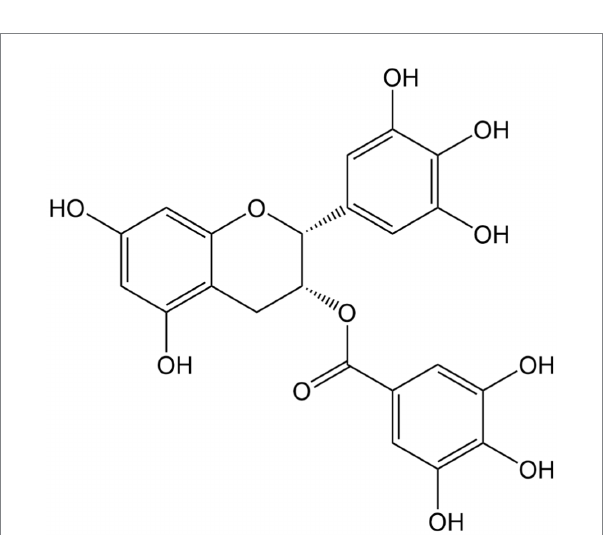
FIGURE 3 Chemical structure of epigallocatechin gallate.